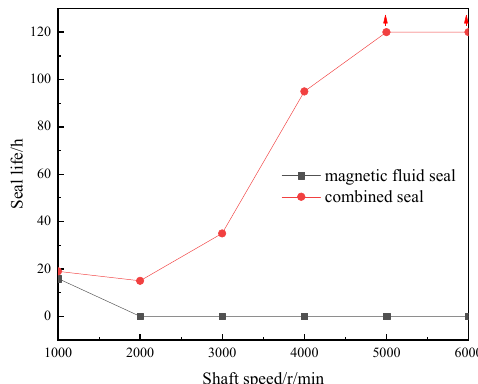
Figure 13. Seal life at different shaft speeds.